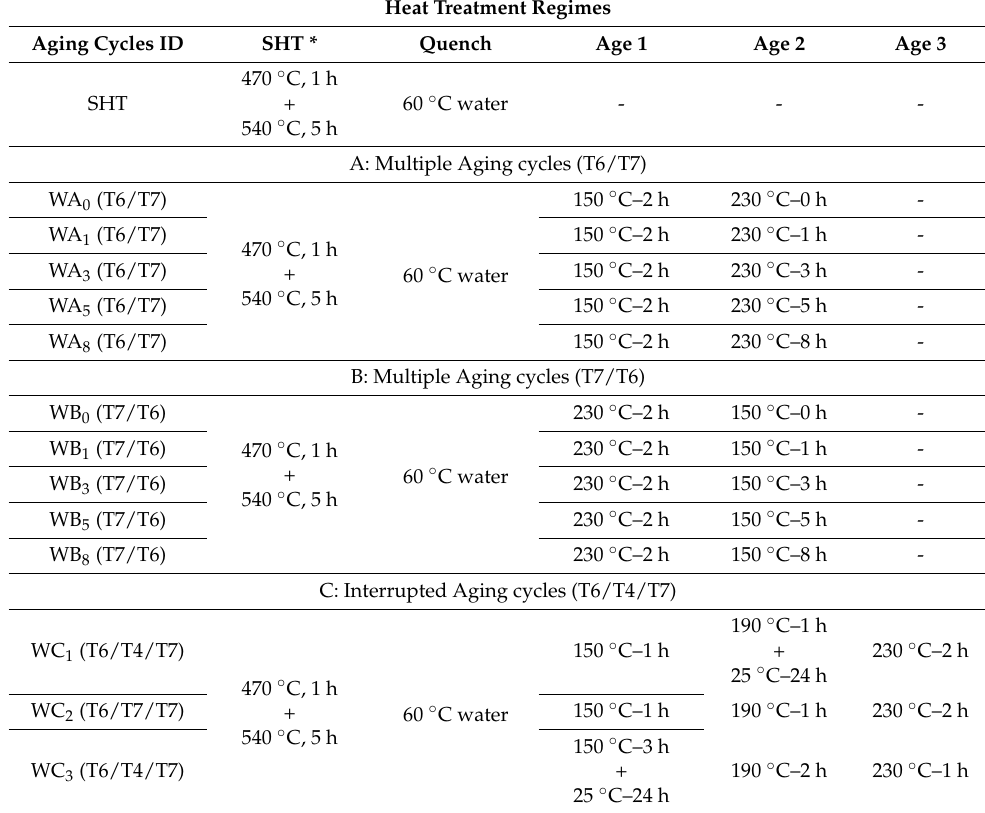
Table 1. Multiple thermal aging cycles employed for A357-SSM